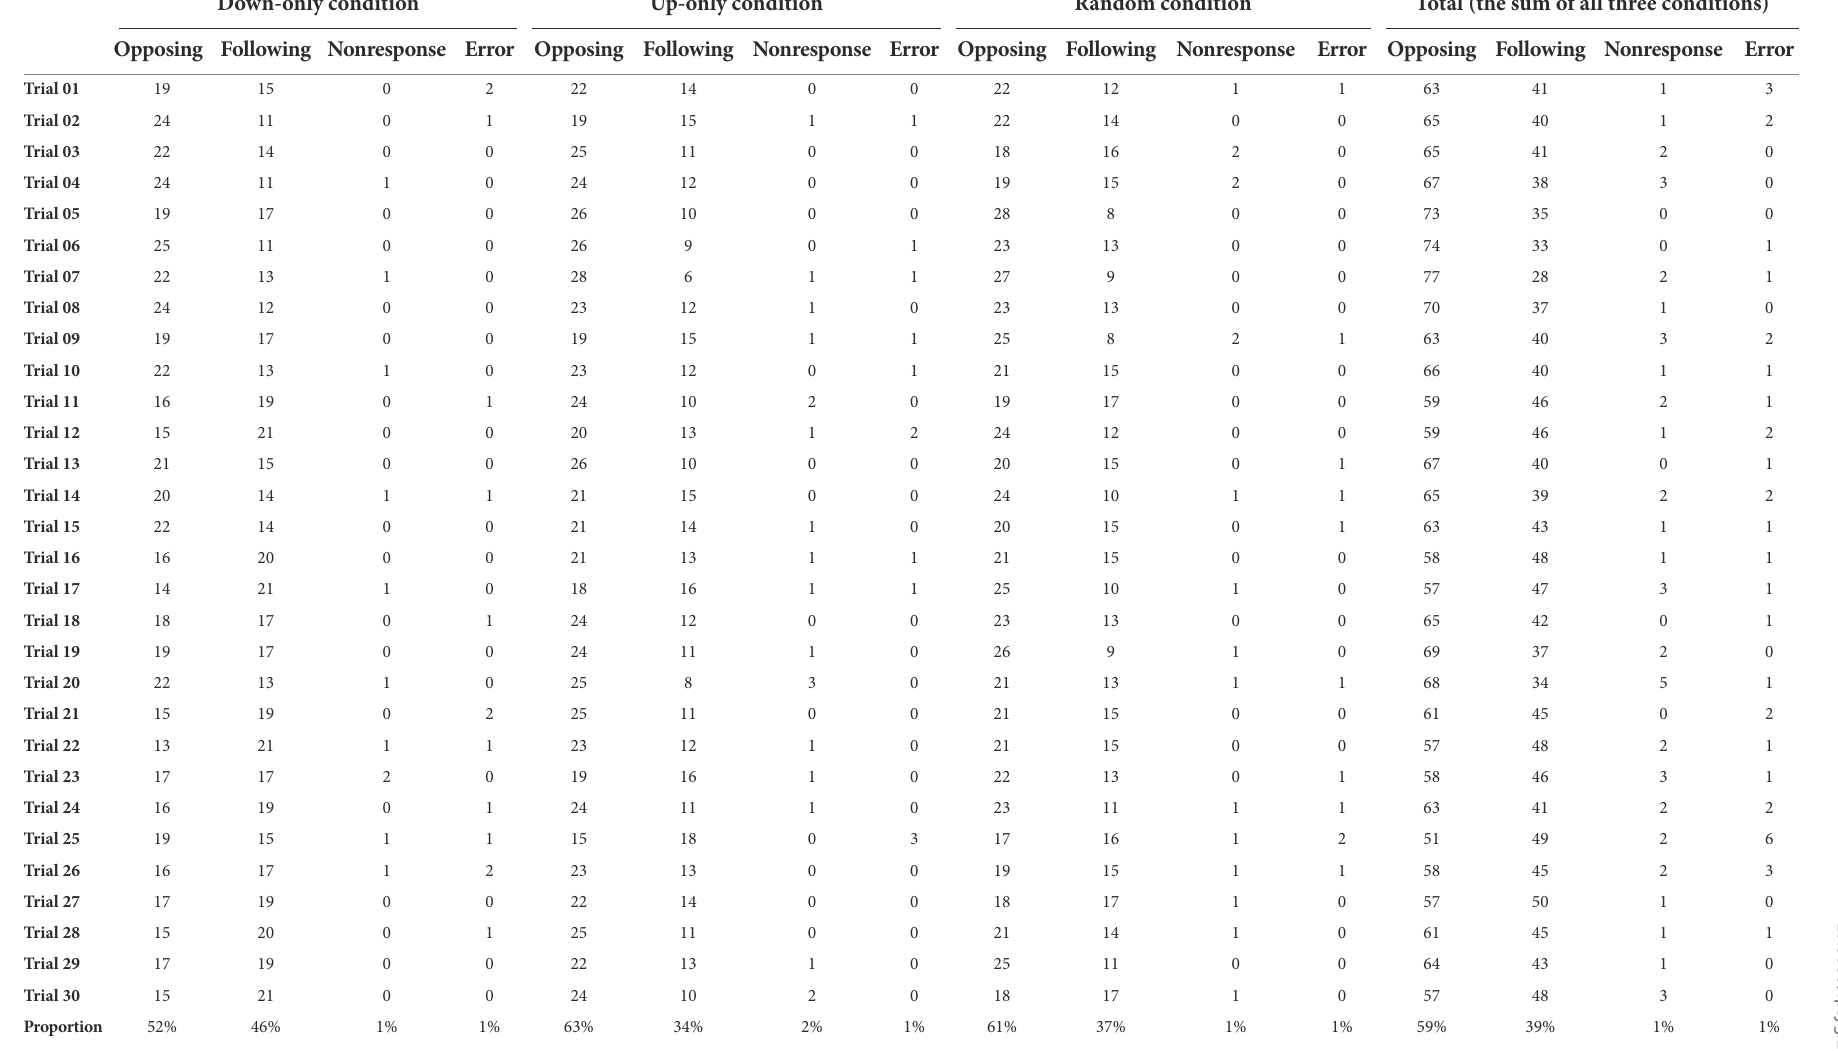
TABLE 1 The frequency (counts) of response types in the 30 trials on the sample size of 36 participants in three conditions. Down-only condition Up-only condition Random condition Total (the sum of all three